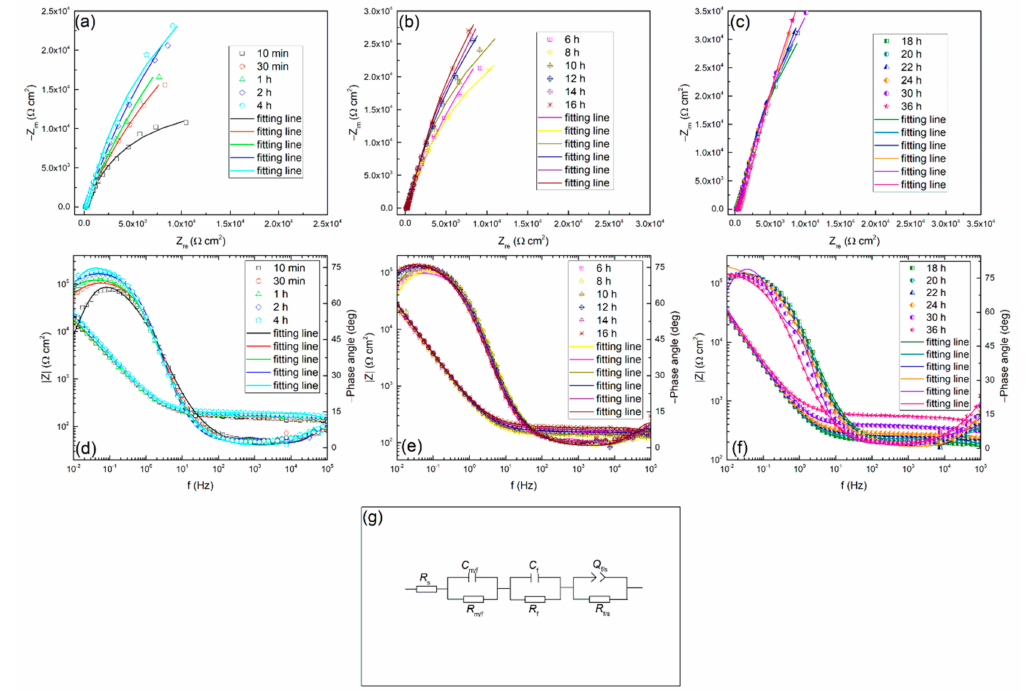
Figure 4. Nyquist ( a ), ( b ), ( c ), Bode ( d ), ( e ), ( f ) plots for TC11 alloy in 0.01 M Na 2 SO 4 solution as a function of immersion time, and ( g ) electrical equivalent circuit used to fit the electrochemical impedance spectroscopy (EIS)